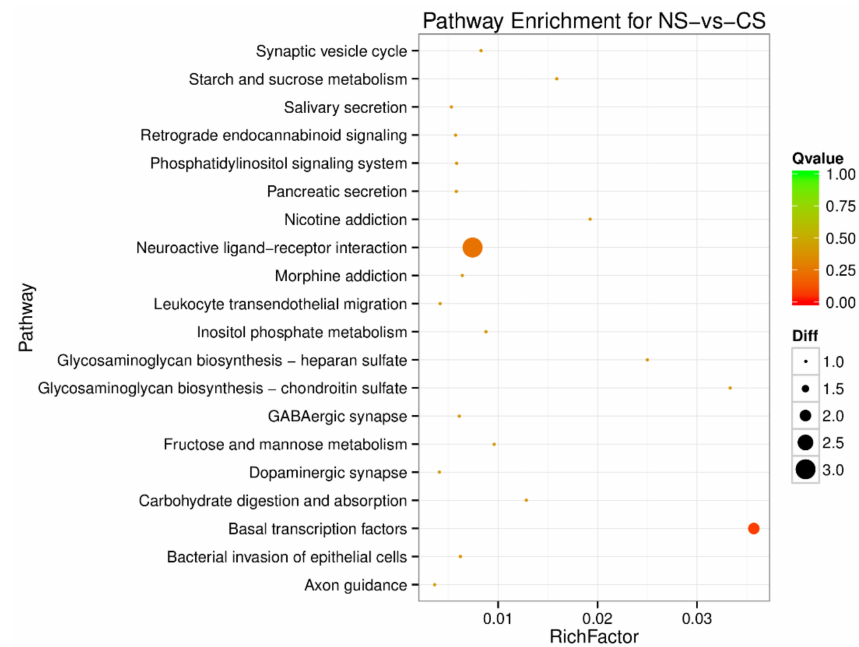
Figure 5. Pathway enrichment analysis of di ff erentially expressed miRNA target genes for NS-vs-cold stress (CS). The larger circle area means the more di ff erently expressed gene number. The Q value represents a significant level ( p -value < 0.05).